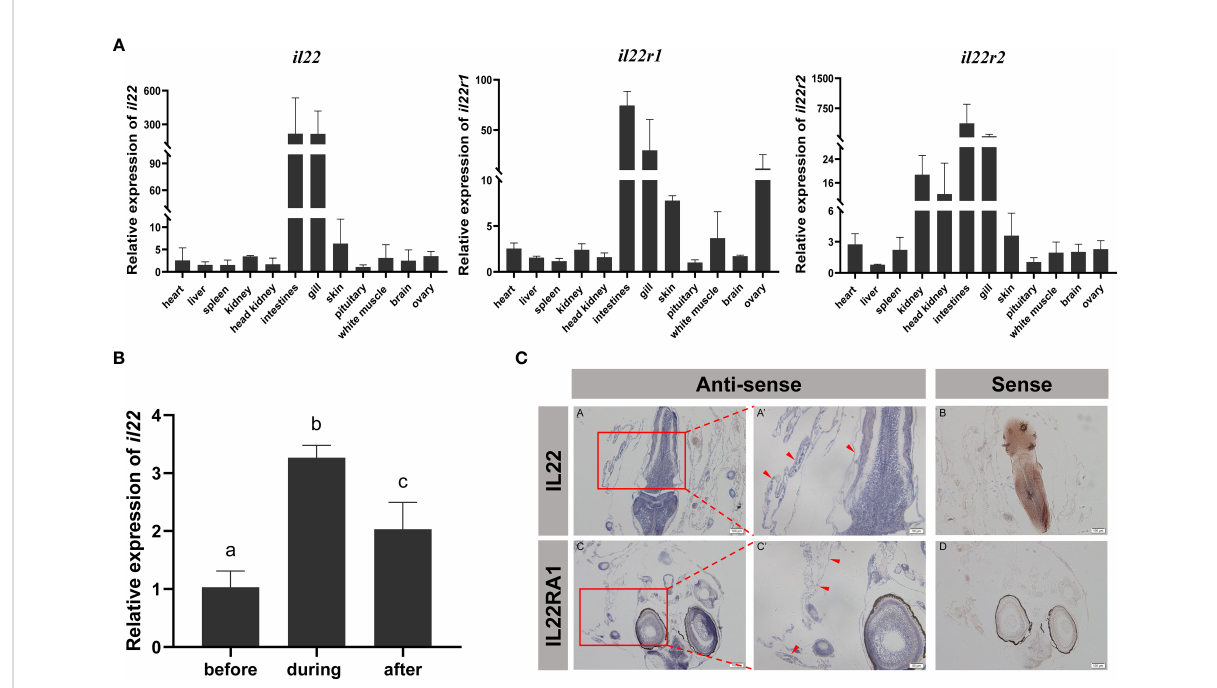
FIGURE 2 Relative expression levels of il22 (A1) , il22ra1 (A2) and il22ra2 (A3) in different organs (heart, liver, spleen, kidney, head kidney, intestine, gill, skin, pituitary, white muscle, brain, and ovary) (n = 3). The X axis indicates different tissues. The Y axis indicates the relative expression normalized to 18s rRNA. (B) Relative expression levels of il22 in black rock fi sh before parturition (n = 5), during parturition (n = 3), and 24 h after parturition (n = 4). The X axis indicates different parturition stage of black rock fi sh. The Y axis indicates the relative expression normalized to 18s rRNA. The data are presented as the mean ± SD. Different letters indicate signi fi cant differences ( P < 0.05). (C) Localization of il22 and il22ra1 mRNA in ovary of black rock fi sh via in situ hybridization. The red arrows indicate positive signals. Scale bars (A – D) = 100 m m. Scale bars (A ’ , C ’ ) = 50 m